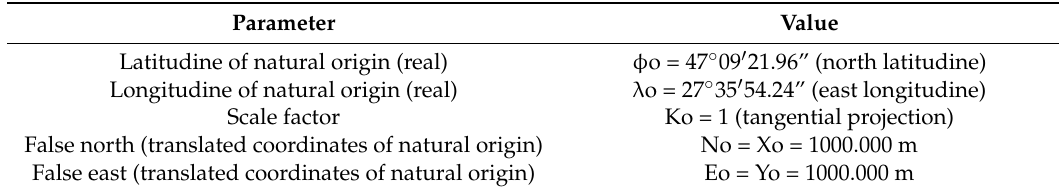
Table 2. “Local-HGIM” stereographical projection